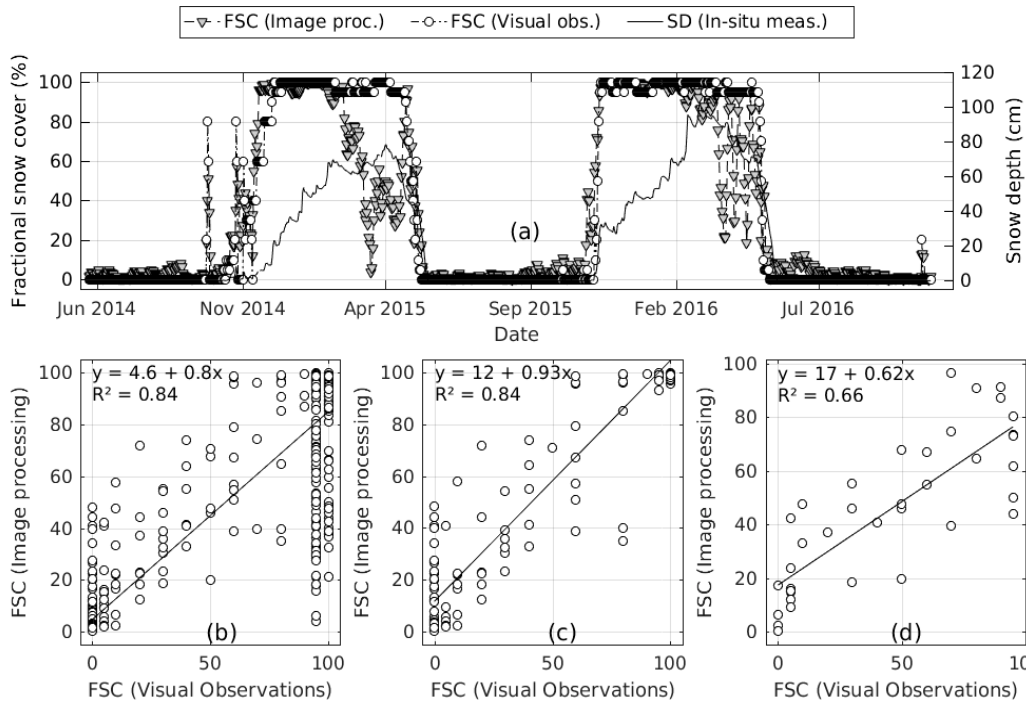
Figure 14. Sodankylä ground camera: ( a ) 3-day moving window averaged fractional snow cover over time from image processing and daily visual observations, daily averaged snow depth over time from automatic ground measurements. Distribution and regression of fractional snow cover from image processing versus visual observations for ( b ) all data; ( c ) early season; and ( d ) melting season.